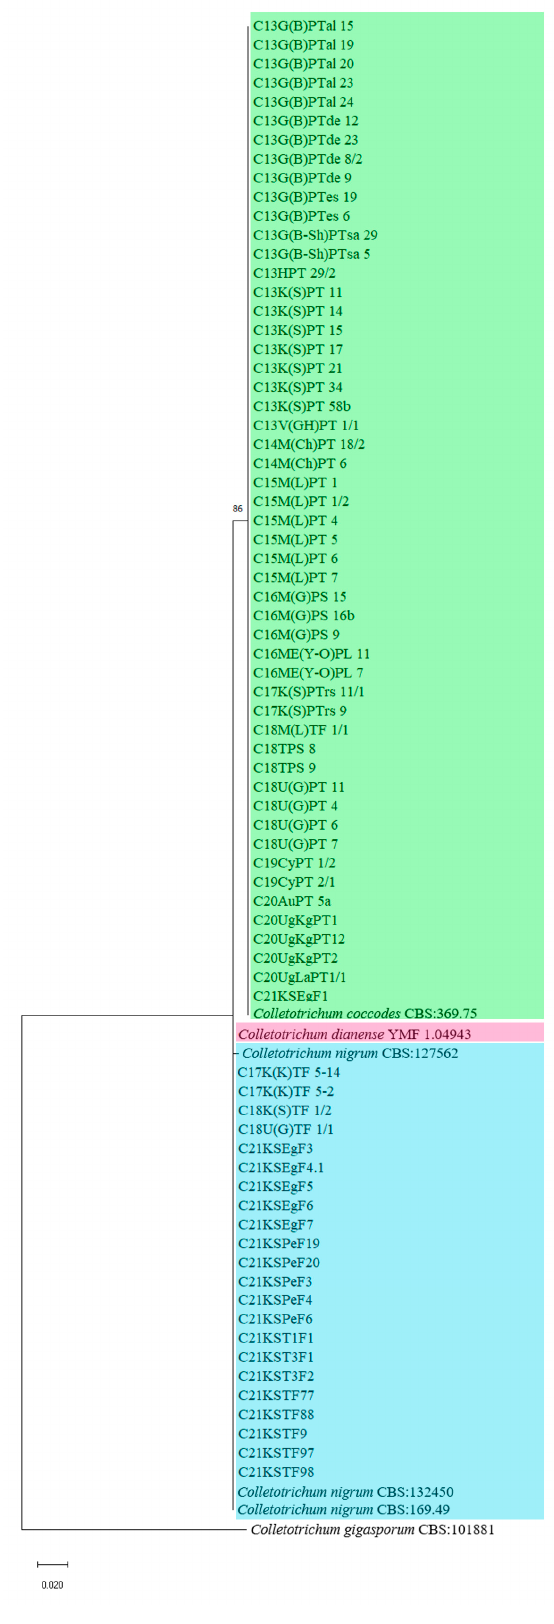
Figure 4. Phylogenetic tree inferred from maximum-likelihood analysis of the actin intron alignment. Bootstrap 1000 replicates. The confidence values are indicated at the branches. Green indicates C. coccodes clade, blue indicates the C. nigrum clade, and red marks C. dianense type species.